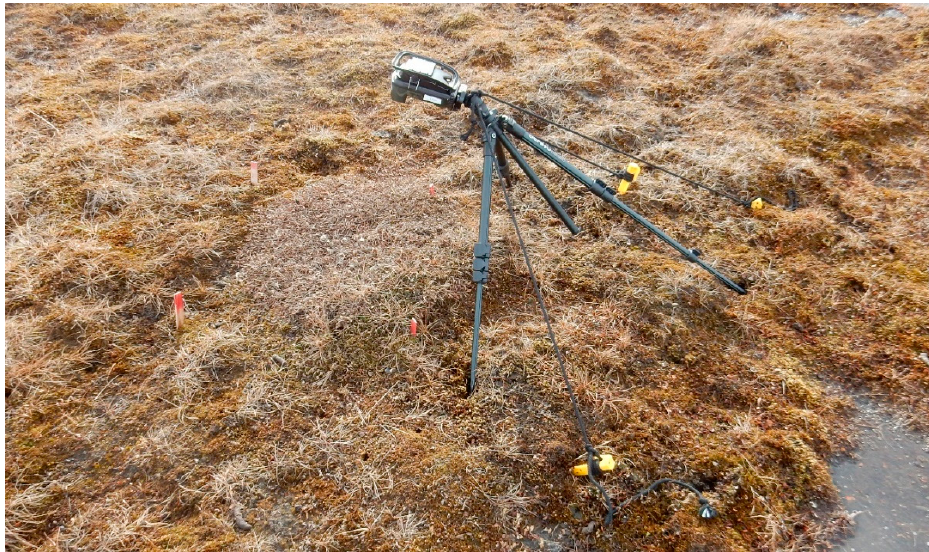
Figure 2. A phenocam on a tripod in Adventdalen valley established to capture images of Dryas octopetala in a moss tundra. Photo from 3 June 2016, eight days before the defined onset of growth of Dryas octopetala that year.